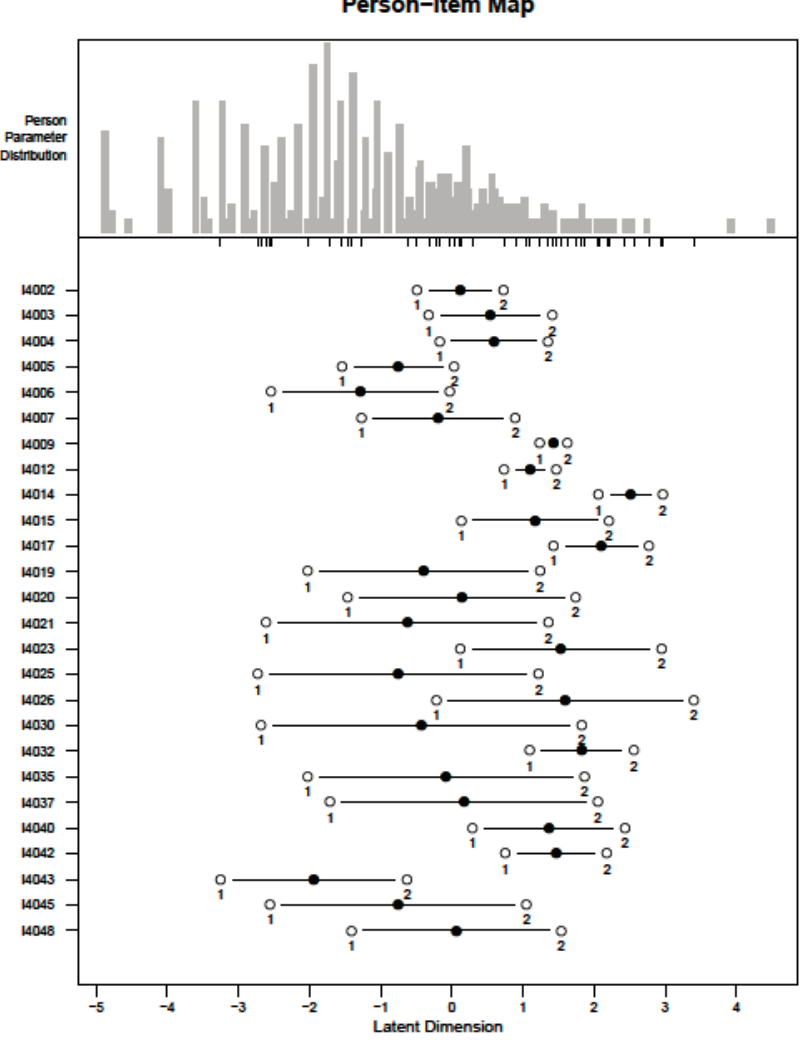
Figure 2. Person-item map of the performance metric built with Rasch